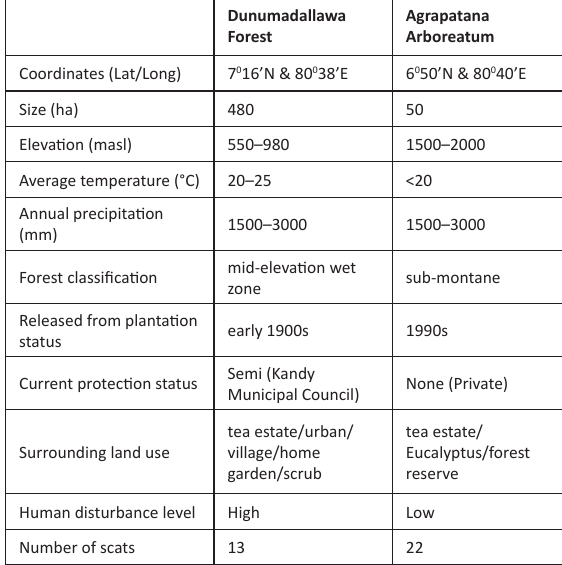
Table 1. Comparison of study areas in central hills, Sri